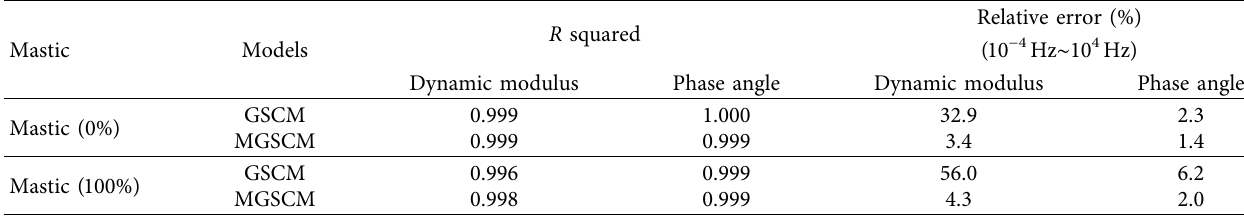
Table 6: Error analysis for complex moduli of asphalt mastics.